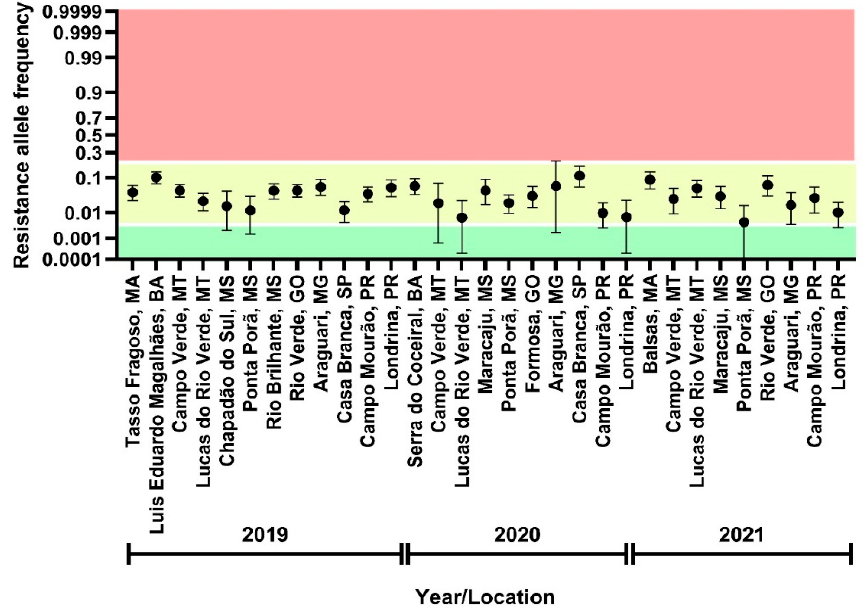
Figure 2. F2 screen results. Frequency of resistance alleles conferring resistance to flubendiamide in Brazilian populations of Spodoptera frugiperda employing F2 screen methodology based on sib-mated F1 isolines of field-collected female adults. In total, 1044, 461 and 469 isolines were tested in 2019, 2020 and 2021, respectively.